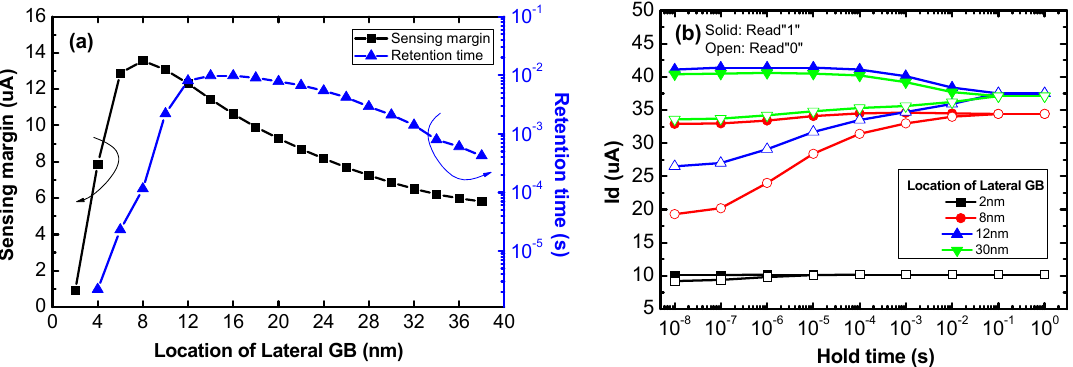
Figure 3. ( a ) The sensing margin and retention time according to the location of the lateral GB and ( b ) the transient characteristics of poly ‐ Si 1T ‐ DRAM devices with varied lateral GB locations.